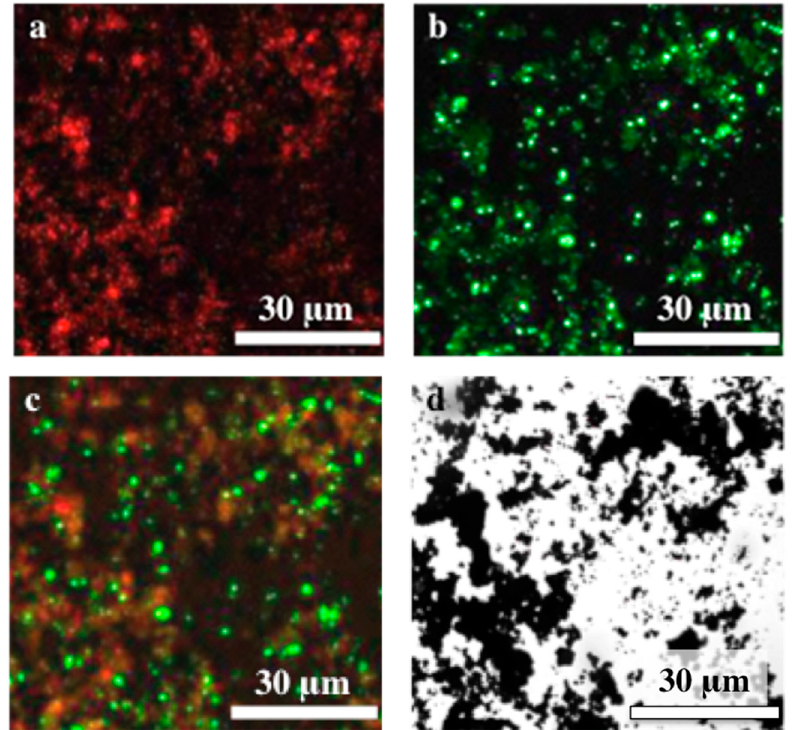
Figure 6. Confocal fluorescence scanning images of ( a ) 430–470 nm emission and ( b ) 505–540 nm emission, ( c ) overlapped image of ( a , b ), and ( d ) wide field image, using a 375 nm laser excitation of p-90Fe.